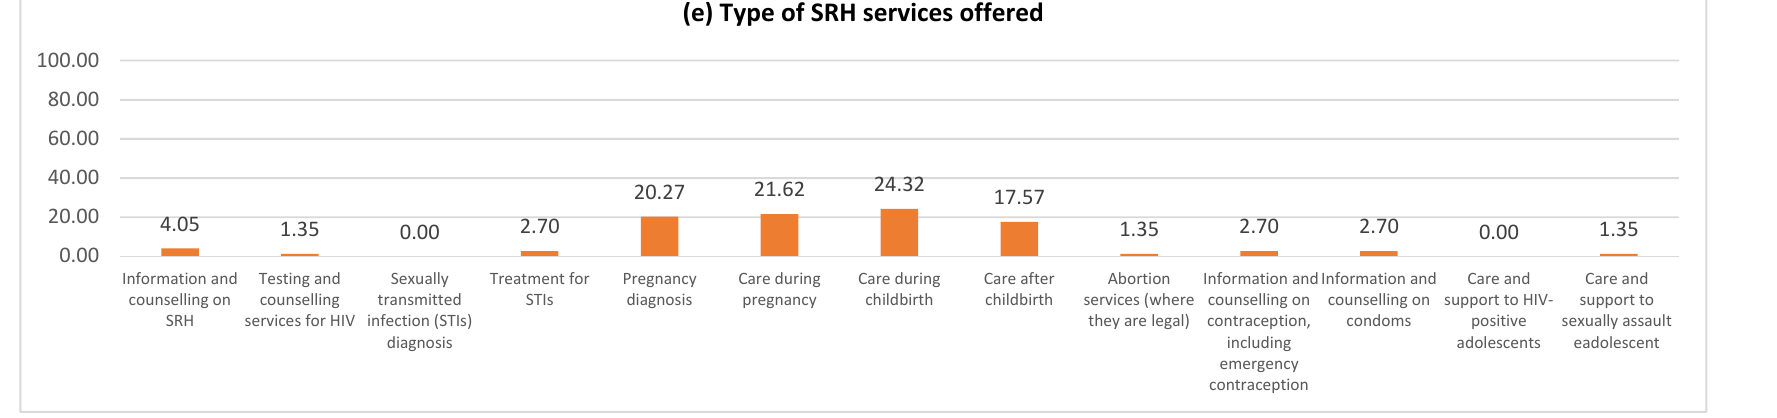
Figure 4. SRH Service provision by health care providers.4. Discussion